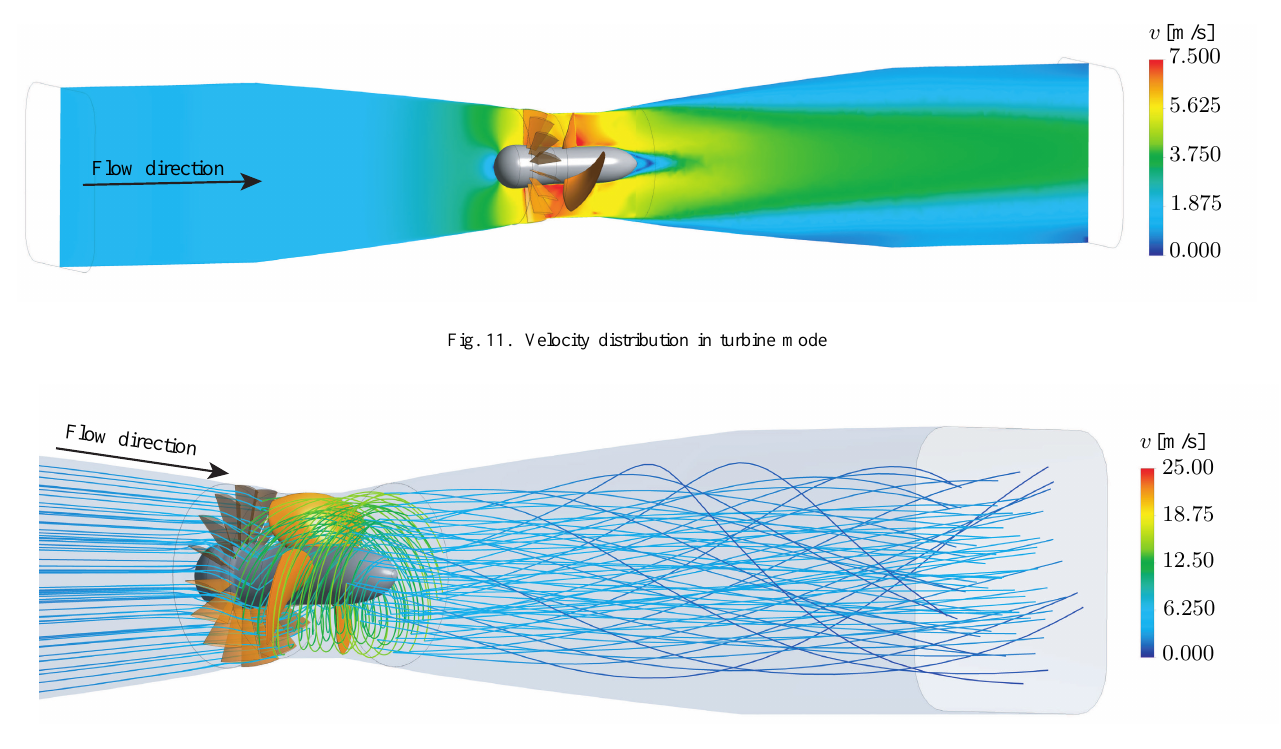
Fig. 12. Streamlines in inlet, guide vanes, runner and draft tube in turbine